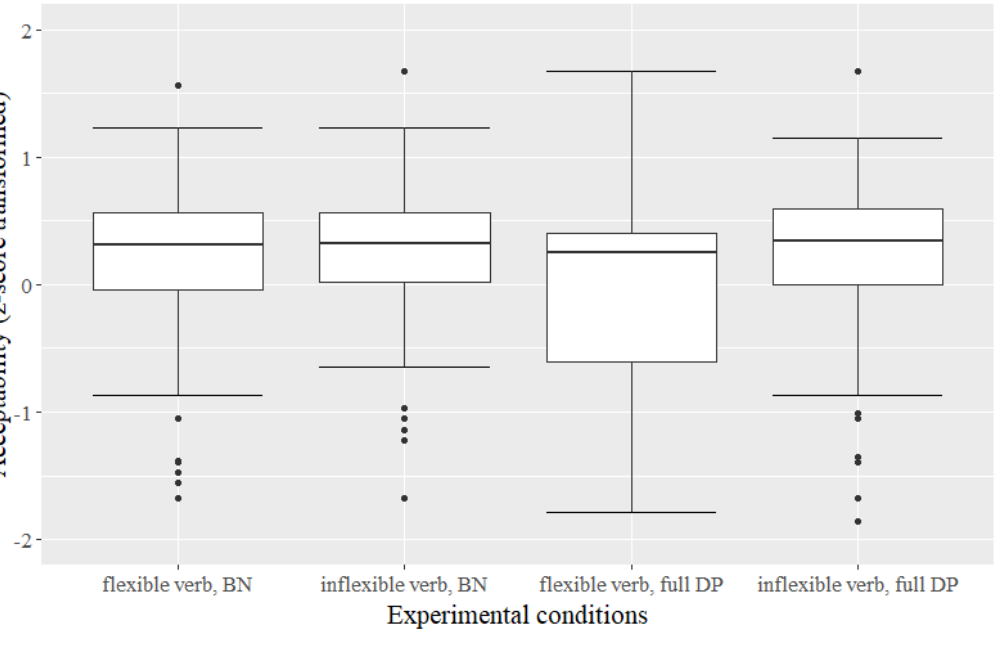
Figure 2. Acceptability of verbs with resultative PPs (N = 310, N for each condition [from left to right] = 79, 76, 80,